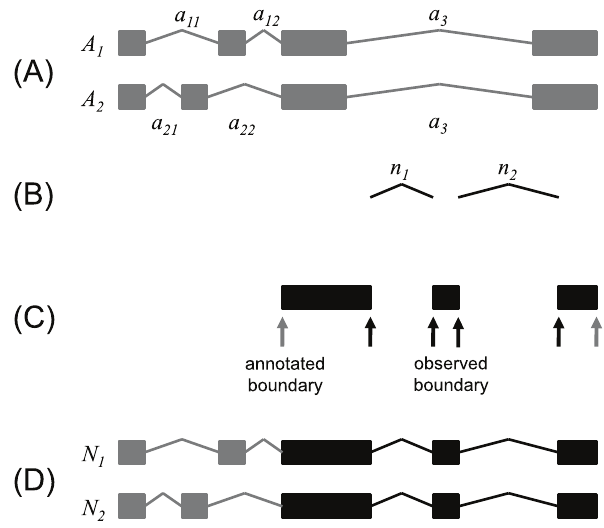
Figure 2. JunctionWalk algorithm. Showing as an example is the application of JunctionWalk algorithm to ( A ) two previously annotated transcripts in the reference database, ( B ) two new junctions identified from RNA-Seq data, and ( C ) three new exons discovered from RNA-Seq data by annotated boundaries in the reference database (gray arrows) or observed boundaries defined by the new junctions from RNA-Seq data (black arrows). A box represents an exon, and a line linking two exons is a junction. From the reference database, transcript A 1 has three annotated junctions of a 11 , a 12 , and a 3 , and transcript A 2 has a 21 , a 22 and a 3 . From RNA-Seq data, previously un-annotated new junctions of n 1 and n 2 are defined. The previously annotated exons and junctions are presented in gray, and new ones are in black. ( D ) The algorithm reconstructs new transcript N 1 and N 2 by walking over the annotated and new exons and junctions.